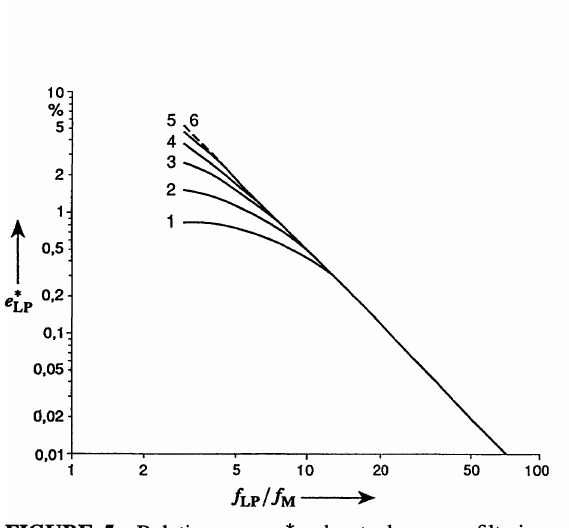
FIGURE 5 Relative error e LP due to low-pass filtering (1st order filter) as a function of the normalized cut-off fre quency fLp 11M. Sinusoidal motion quantity with frequency 1M and deflection am~litude x. Parameter is the normalized amplitude xl fl.x = 4'!' 1,2, and 4 for curve 1, 2, 3, 4 and 5, respectively. Curve 6 shows a function proportional to (fLpIIM)-2 as an